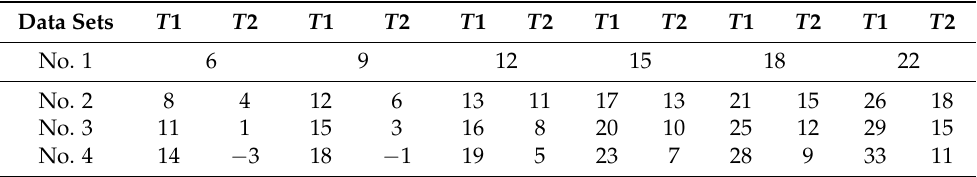
Table 4. EIS test procedures B1 at artificial temperature gradients at 50% SoC.